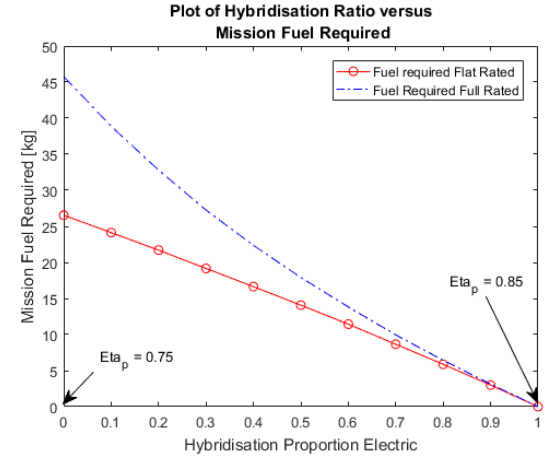
Figure 8. Skydive mission fuel required assuming off-board recharge.